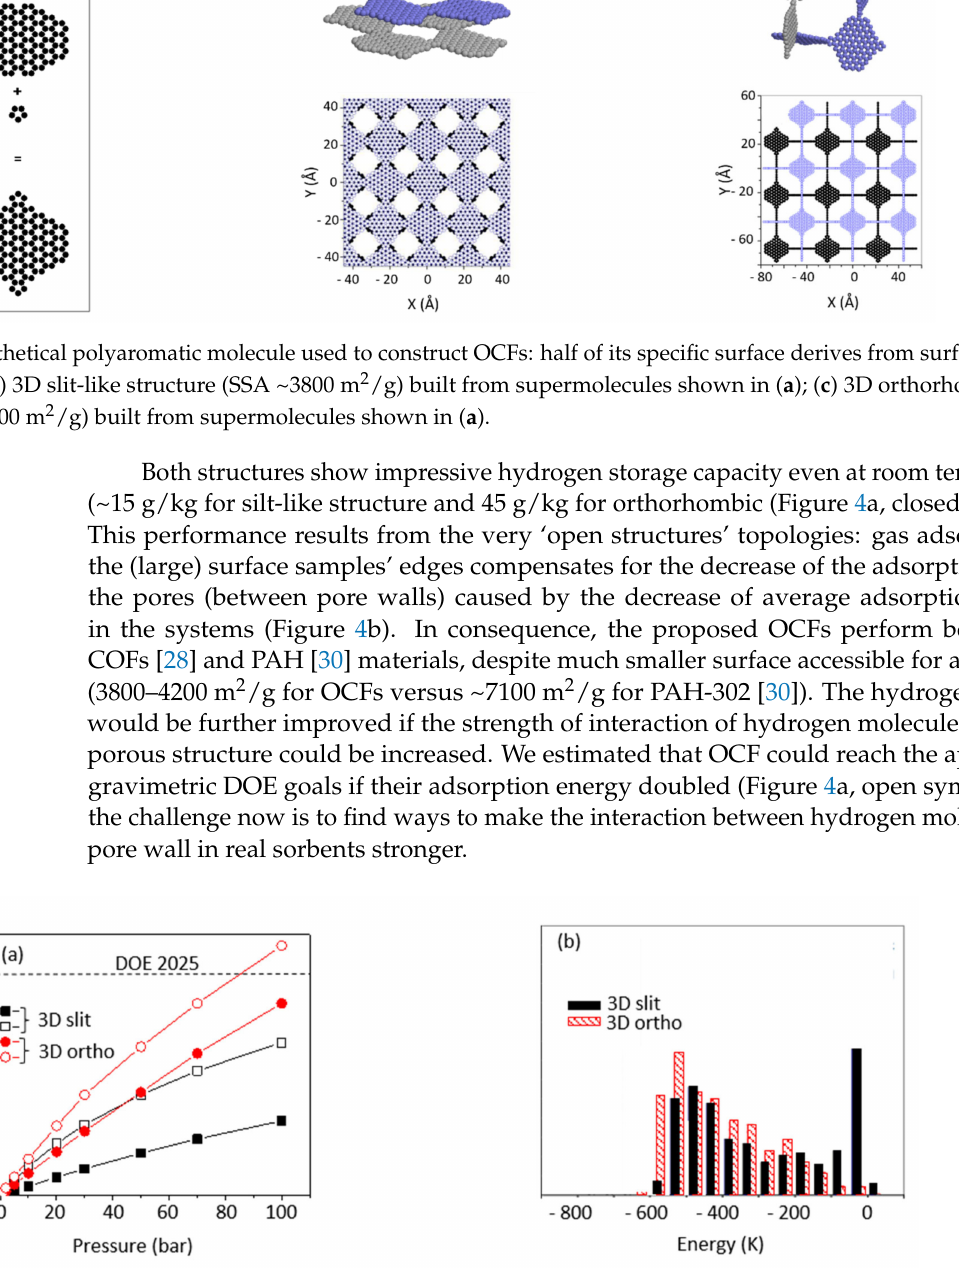
Figure 4. ( a ) Isotherms of total hydrogen adsorption in 3D slit-like and orthorhombic structures from Figure 3b,c. Open symbols refer to interaction model two times stronger that H 2 –C interaction; ( b ) distribution of adsorption energy in 3D slit-like and orthorhombic